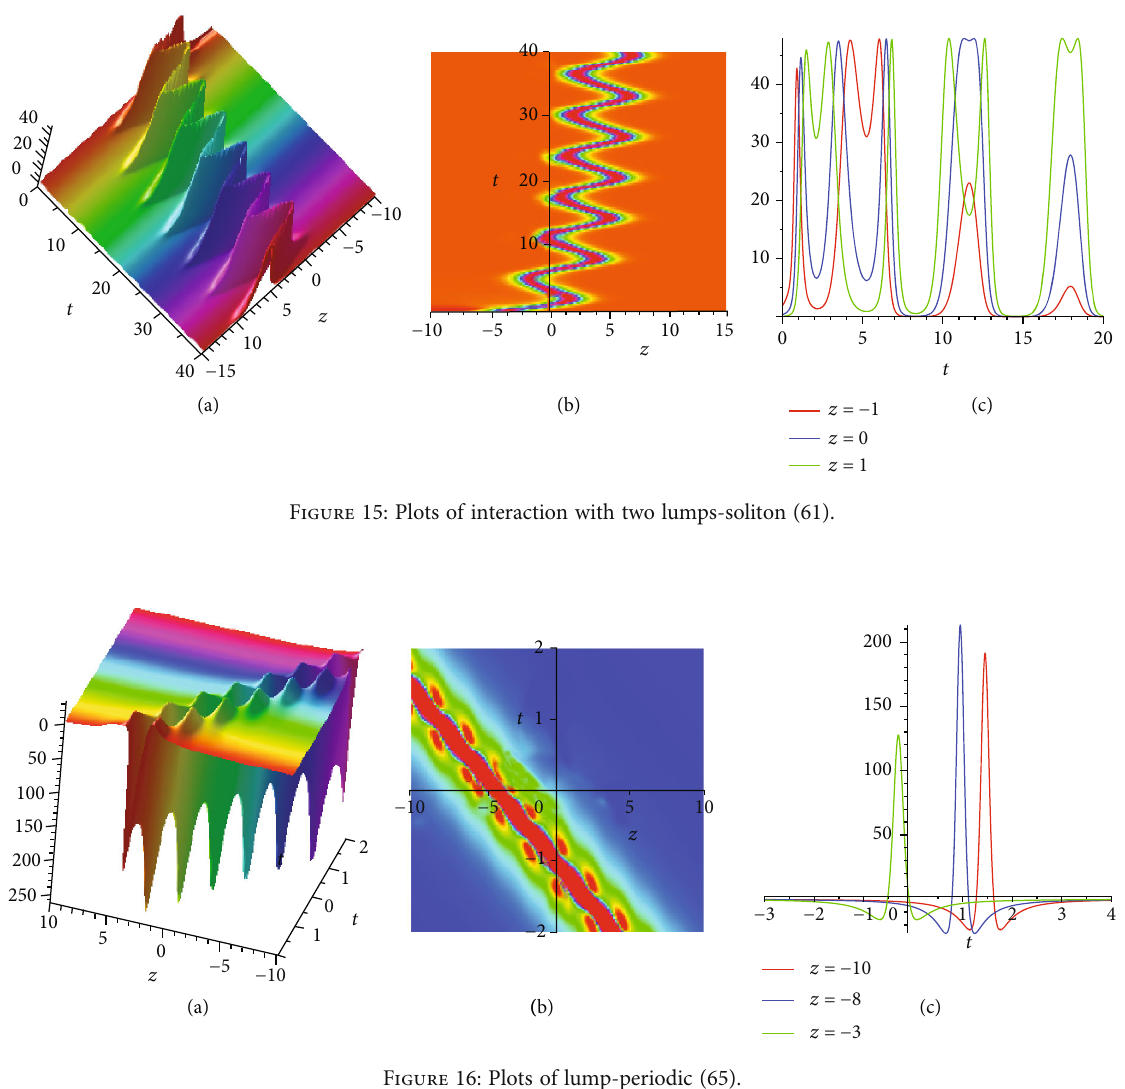
Figure 16: Plots of lump-periodic